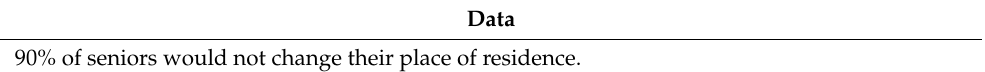
Table 12. Profile of the future of a Polish senior. Source: own elaboration on the basis of [90–101].